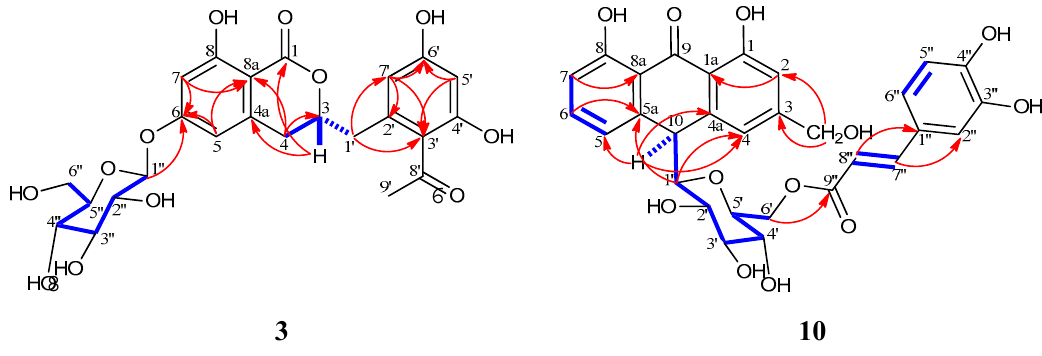
Figure 2. Selected COSY ( ) and HMBC (H C) correlations for compounds 3 and 10 .